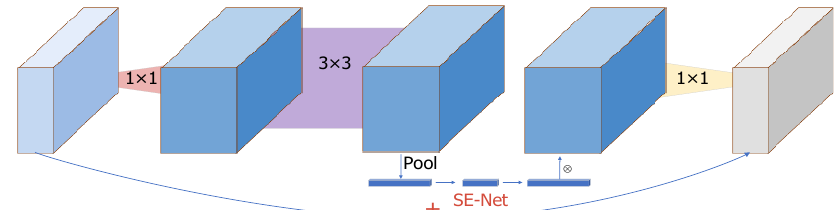
Figure 11. Inverse residual structure of MobileNetV3.